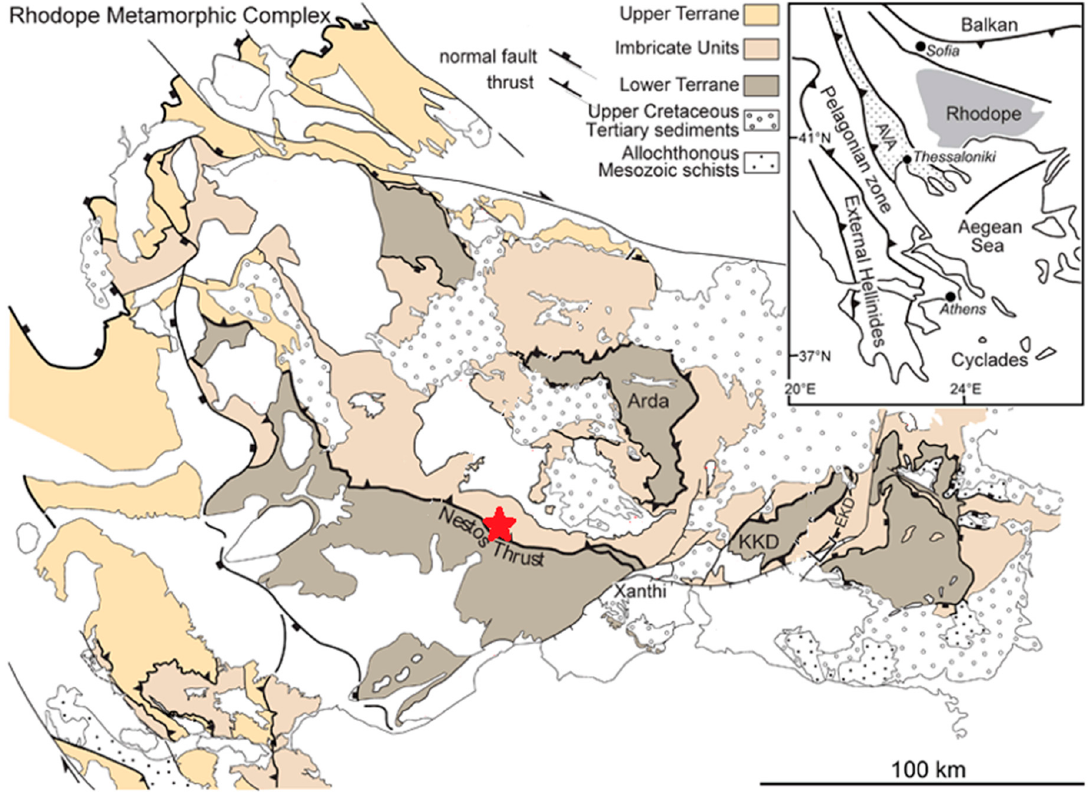
Figure 1. Geological map of the Rhodope Mountain Complex, with Paranesti located within the Nestos Shear Zone (red star) (Adapted from Moulas et al, 2017 [17]).